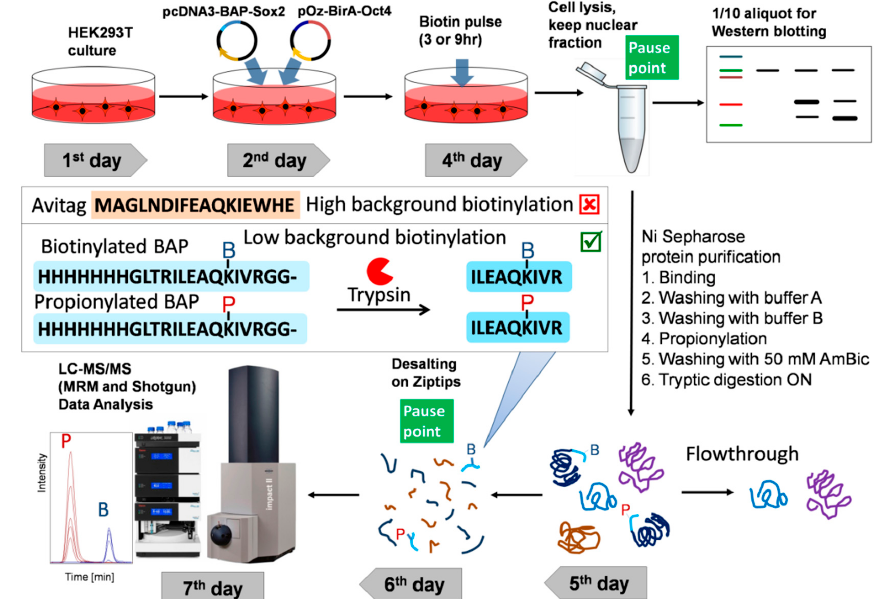
Figure 1. Experimental workflow for the detection and quantitative analysis of protein–protein interactions (PPI) between pluripotency transcription factors. Cells expressing biotin acceptor peptide (BAP)-Sox2 and BirA-Oct4 were labelled by biotin (3 h or 9 h) before harvest. The cells were lysed in cytoskeleton (CSK) buffer with 0.5% Triton X-100 to isolate the nuclei. The nuclear fractionsere incubated on Ni-sepharose beads to purify and enrich the fused proteins. The Ni-sepharose-bound proteins were treated by propionic anhydride, washed, and digested on the beads with trypsin, and the tryptic peptides were desalted by Ziptips. The peptide mixtures were then analyzed by LC– MS/MS. The propionylated and biotinylated BAP peptides were identified and quantified using Data Analysis software.